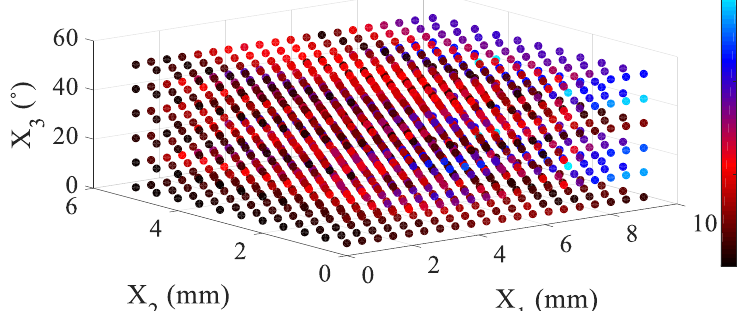
Figure 14. T Cog (Nm) vs X 1 vs. X 2 vs. X 3.